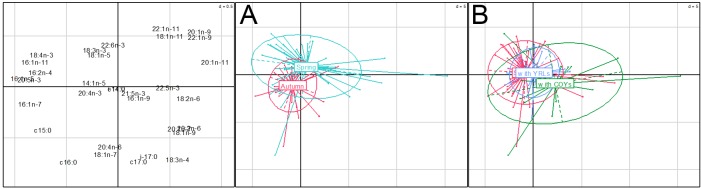
Ordination plots from fatty acids (FA) principal component analysis (PCA) scores grouped by (A) season and (B) breeding status. PCA was based on mass percentage of total dietary fatty acids (FAs) relative to FA 18:0, in female polar bears sampled in Svalbard in 2012–2013. The first and second axes explained 31.6% and 16.7% of the total variation, respectively. FA contribution to each axis appears on the left panel. On panels A and B, each dot represents an individual. Individuals with similar FA composition (PCA scores) are near each other and individuals with dissimilar FA composition are farther from each other, the center of the star linking all individuals of a same group represents the centroid of PCA scores for that group.